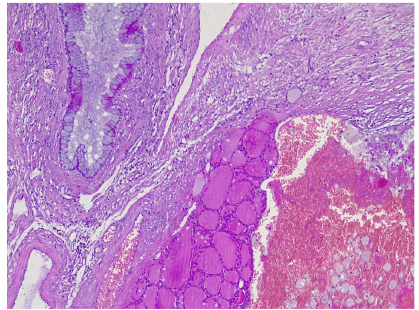
Figure 10. Carcinoid and mucinous cystadenoma. HE, 4 ×